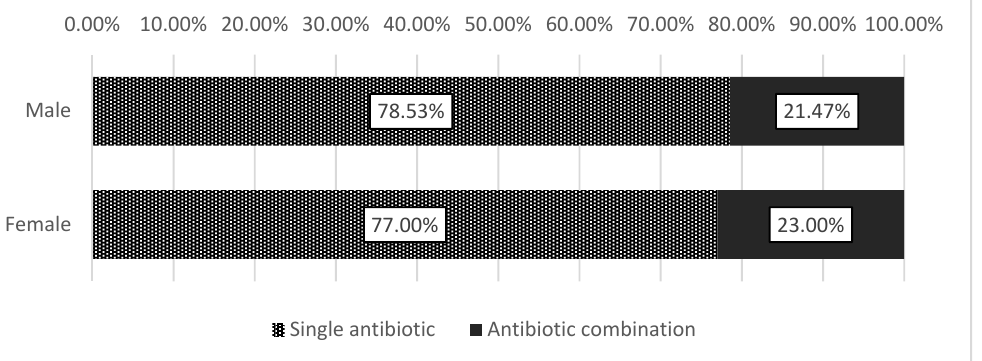
Figure 2. Prevalence of dispensing combination antibiotic therapy in patients of different sex groups during one year (combination antibiotic therapy defined as receiving a prescription for two or more different antibiotics during one visit).